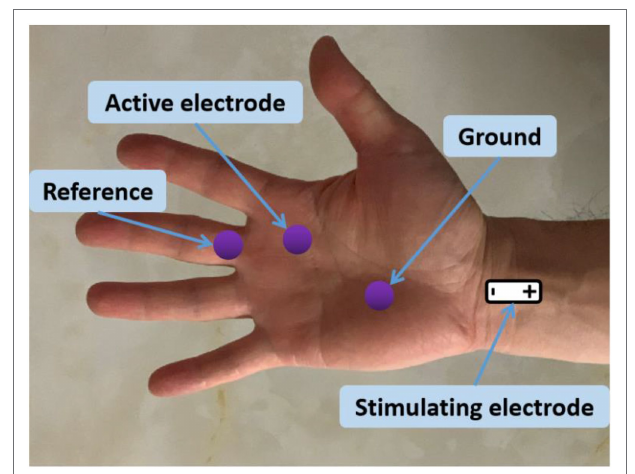
FIGURE 1 | Electrode placement for CMAP scan recording of the second lumbrical muscle. Hand muscle anatomy showing the lumbricals can be found in